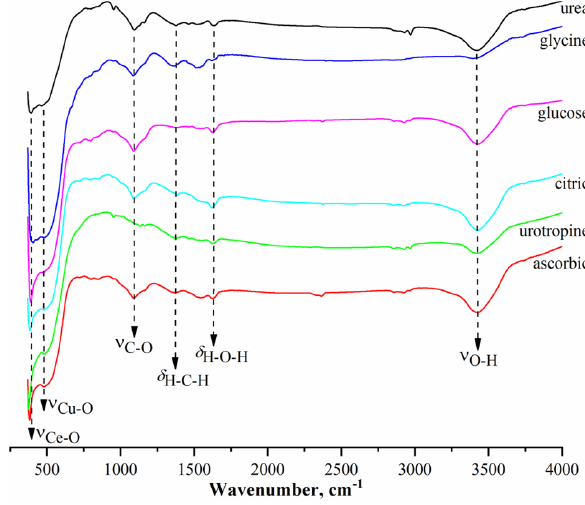
Figure 4: FTIR spectra of the synthesized CuO/CeO 2